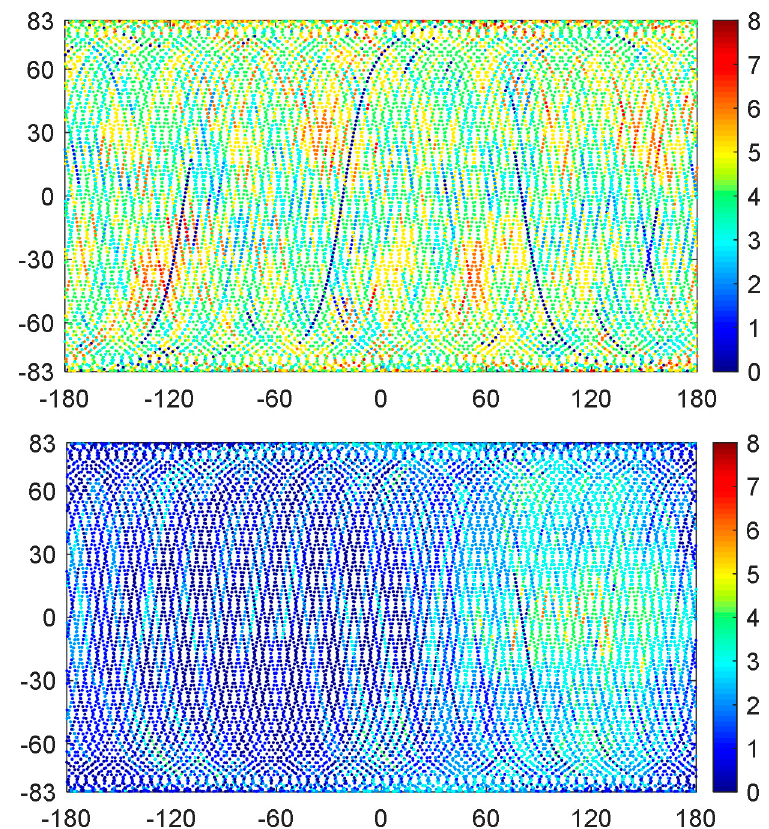
Figure 5. The useful number of GPS ( top panel ) and BDS ( bottom panel ) satellites per epoch along the CSES satellite ground tracks from DOY 202 to 206, 2018.